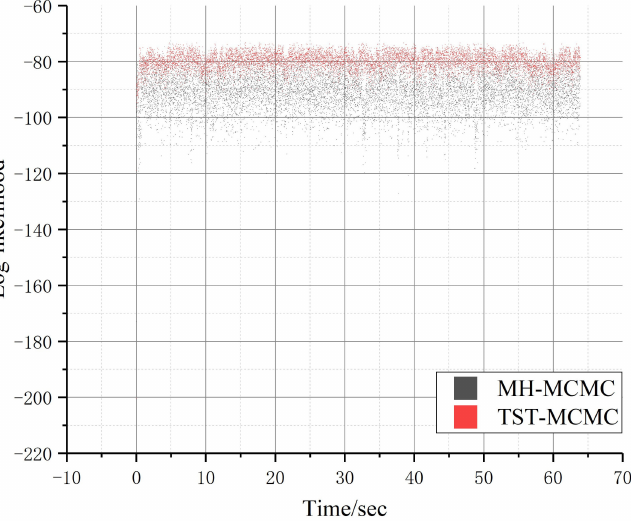
Figure 10. Comparison of two algorithms in Zachary Karate Club network (relationship between log-likelihood and iterations, in which the red scatter represents TST-MCMC algorithm and the black scatter represents MH-MCMC